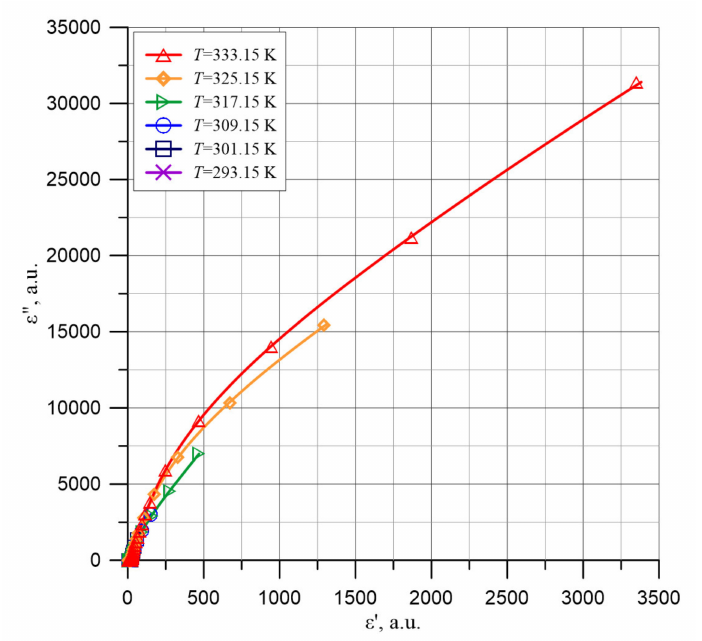
Figure 13. Cole-Cole diagrams in the area of high permittivity ε (cid:48) for the composite of cellulose, transformer oil and water nanoparticles for temperatures from 293.15 to 333.15